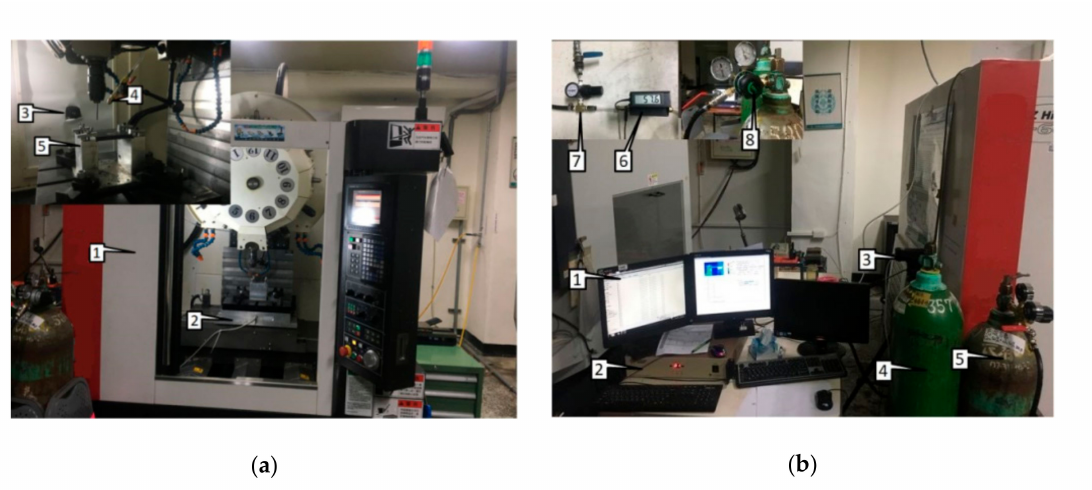
Figure 3. The drilling process system ( a ) 1. Litz Hitech TV-600 Tap and Drill computer numerical control (CNC) machine; 2. Dynamometer; 3. Thermal camera; 4. Air nozzle; 5. Fixture; ( b ) 1.